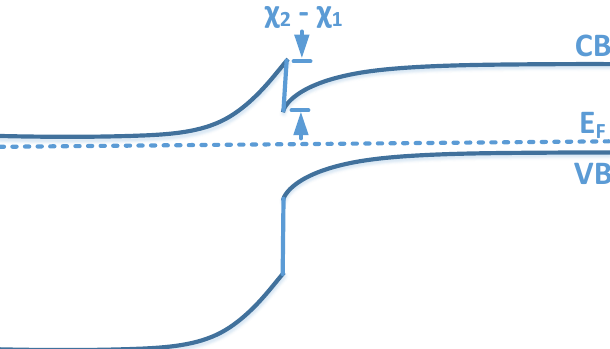
Figure 4. Schematic of the band-bending when electron affinity of ZnO ( χ 1 ), at left, is lower than that of Si ( χ 2 ), at right. CB: conduction band, VB: valence band, E F : fermi level.